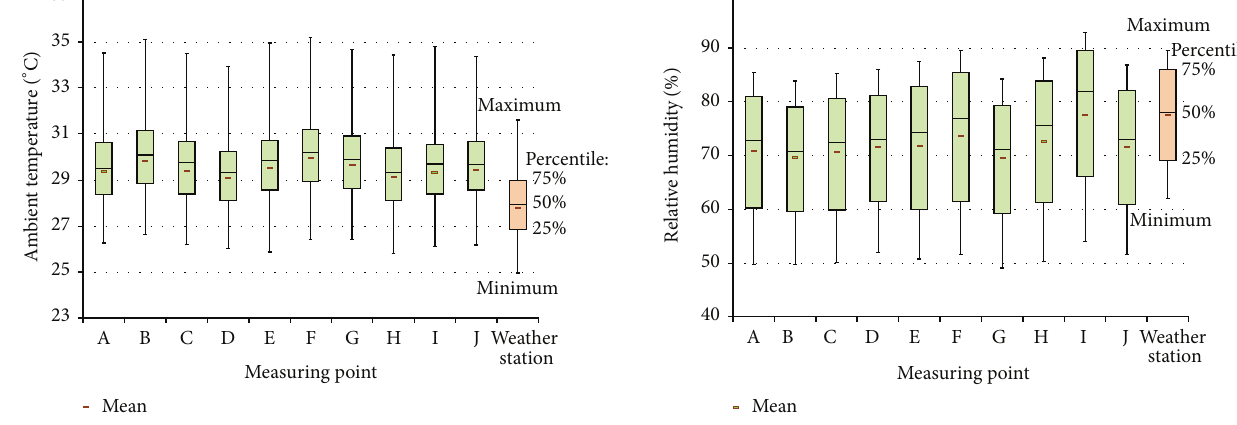
Figure 4: Variation of daily mean ambient temperature of all selected sites as well as the weather station during July to October 2013.